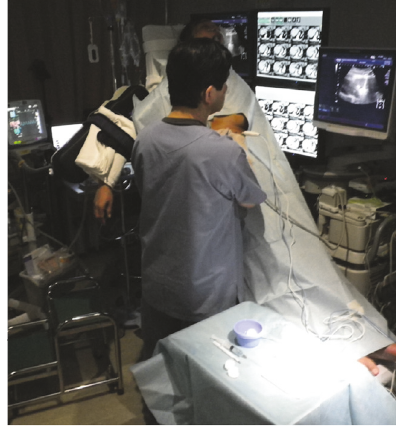
Figure 2: We developed a dedicated procedure bed. Using this bed, we can keep a patient in an optimal position, such as right hemilateral decubitus position, left hemilateral decubitus position, head-up position, sitting position, and almost standing position.